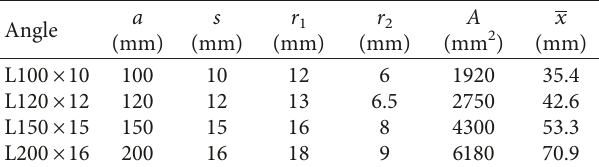
Table 2: Details of angle sections.